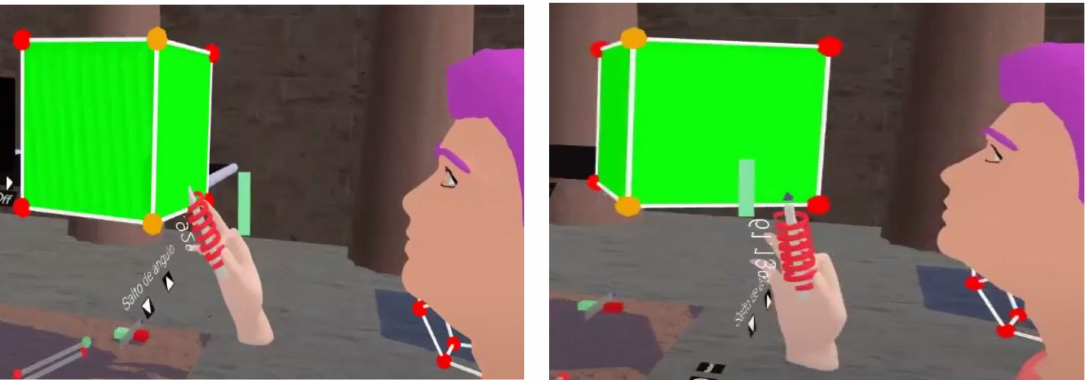
Figure 2. Using the rotation tool.